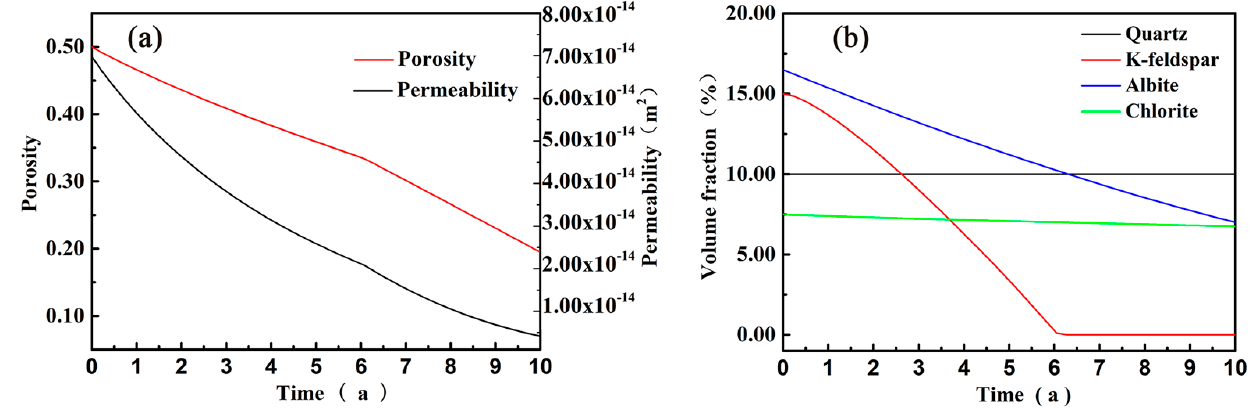
Figure 6. Time-varying simulation results at the injection point. ( a )—Porosity and permeability; ( b )—Primary minerals.